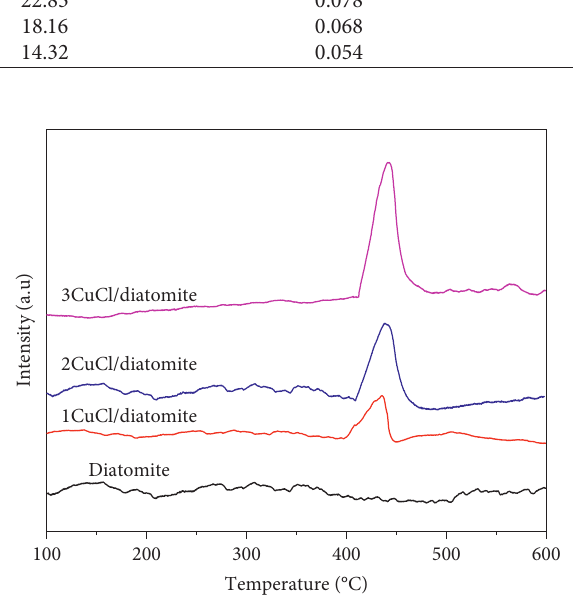
Figure 7: CO-TPR profiles of diatomite and CuCl-modified diatomites.